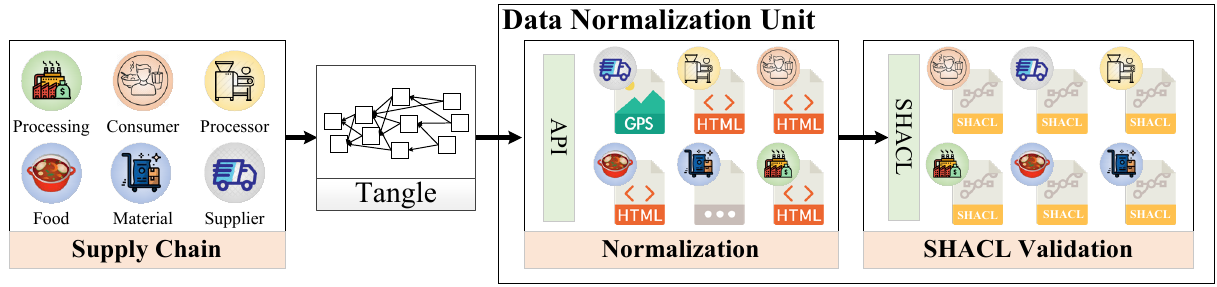
Figure 3. The working flow of the data normalization unit.